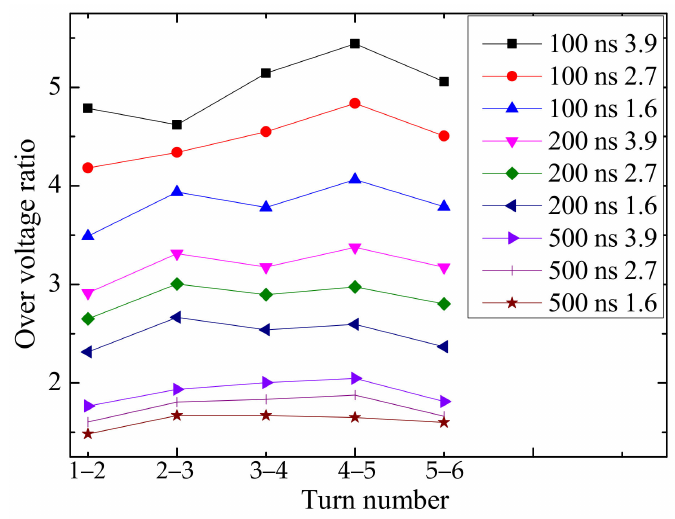
Figure 16. Interturn overvoltage ratio under different rise times and relative permittivity.